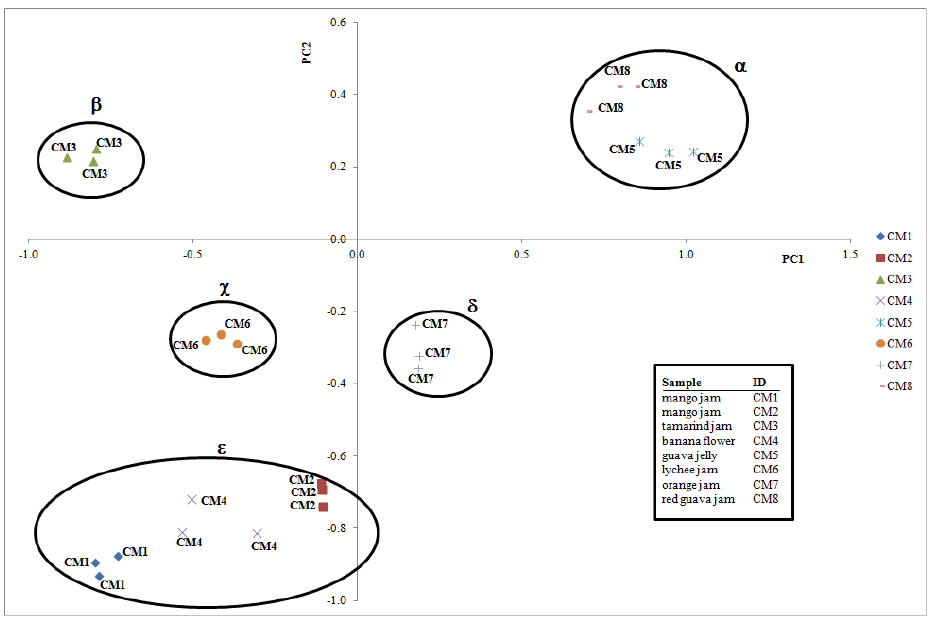
Figure 5. PCA score plot of fruit ‐ derived products (eight samples and three replications per sample). The ellipses around each object group only indicate the position of a category in the plot without statistical meaning, based on the phytochemical results.